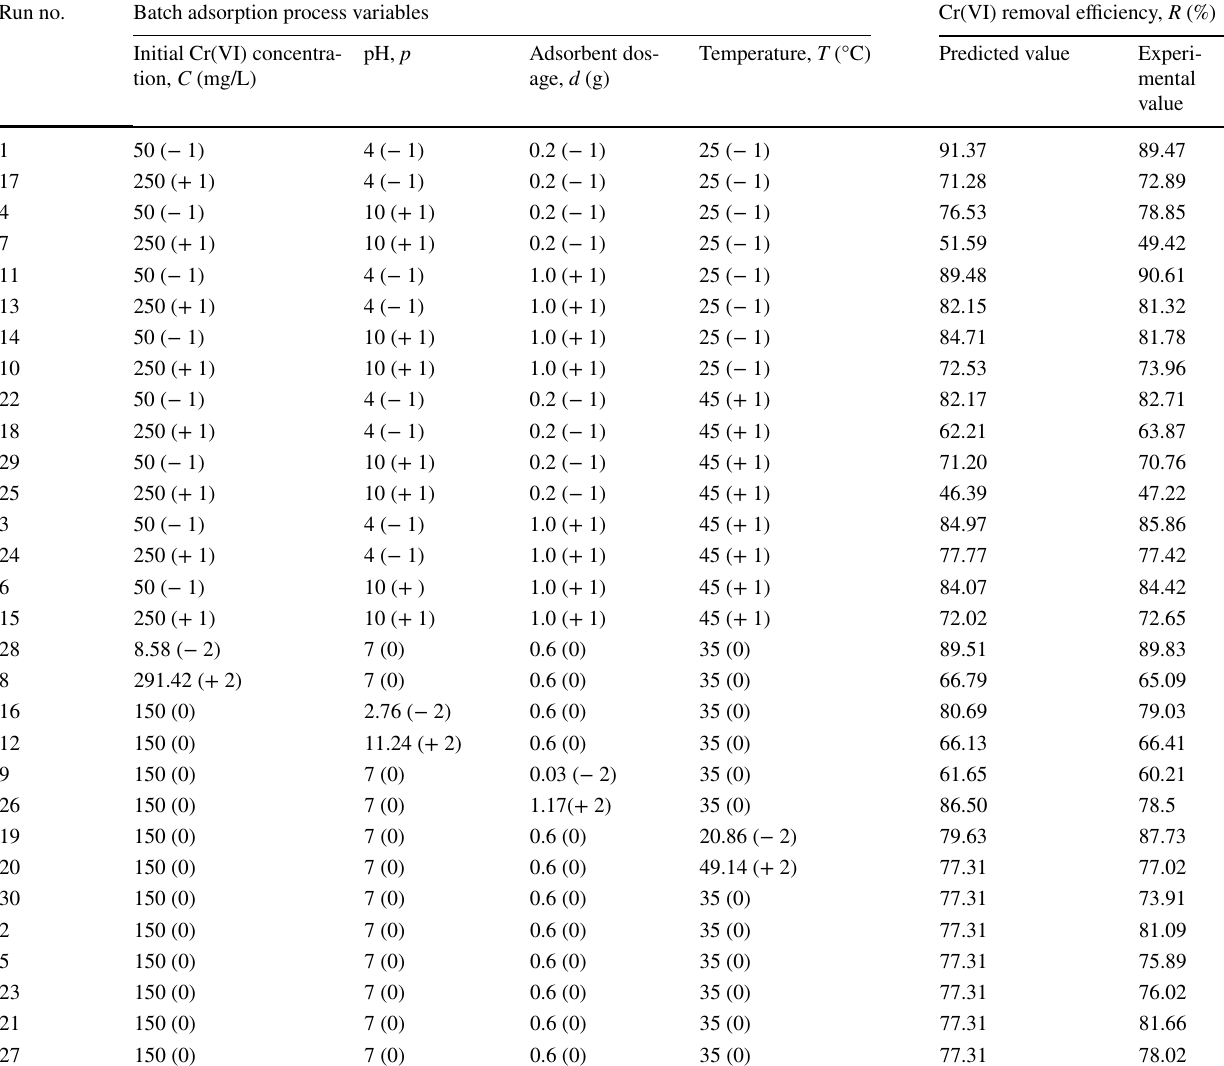
results Run no. Batch adsorption process